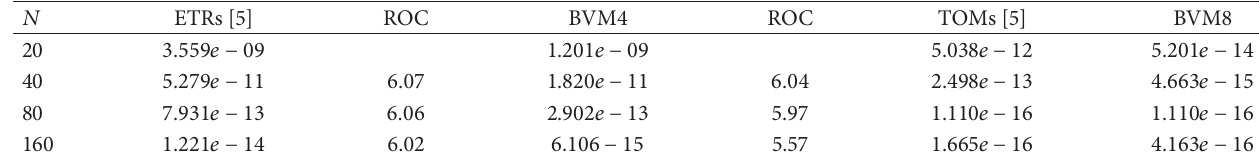
Table 6: Maximum Errors for different stepsizes for Example 4 for 𝜆 = 0.1 .